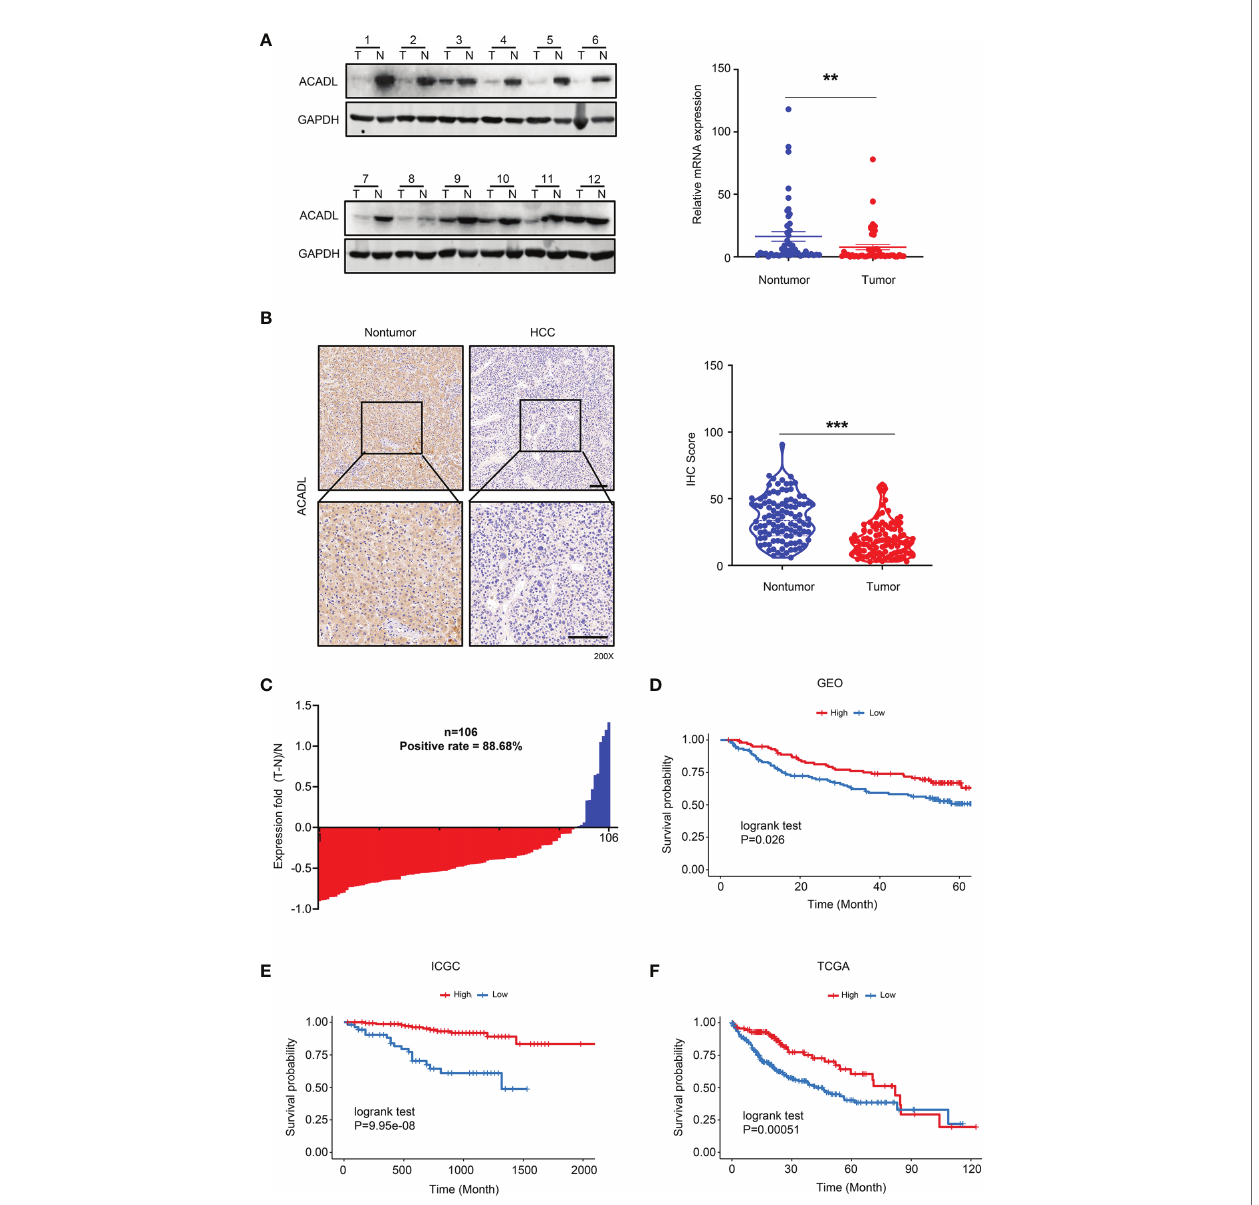
FIGURE 1 | Reduced expression of ACADL is associated with poor prognosis in HCC. (A) ACADL protein levels (n = 12) and mRNA expression levels (n = 46) in paired HCC and adjacent nontumor tissues obtained from our center by WB and qRT-PCR analyses, respectively. A paired-sample t-test was performed. (B) Expression of ACADL in HCC tissue microarray was tested by IHC staining. Representative micrographs showed the expression levels of ACADL in tumors tissues and adjacent nontumor tissues. The measurement of all 106 specimens was quanti fi ed using Image J software. Original magni fi cation, 100×, 200×. A paired- sample t-test was conducted. (C) Scatter plot analysis of the immunoreactive score in matched human tissues of HCC and adjacent nontumor tissues. (n = 106) (D – F) Survival plots for groups with high and low expressions of ACADL expression in three LIHC cohorts. **P < 0.01, and ***P < 0.001 compared with